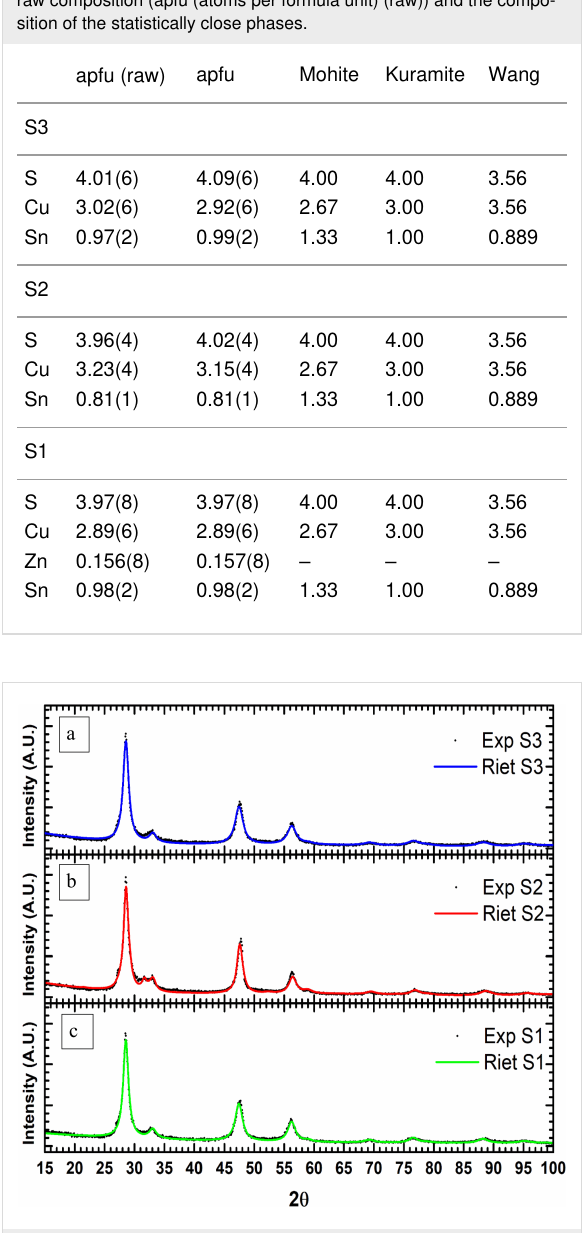
Figure 3: Experimental and calculated diffractograms and related models for sample a) S3, b) S2 and c) S1. Exp and Riet are the experi- mental data and the Rietveld refinement,